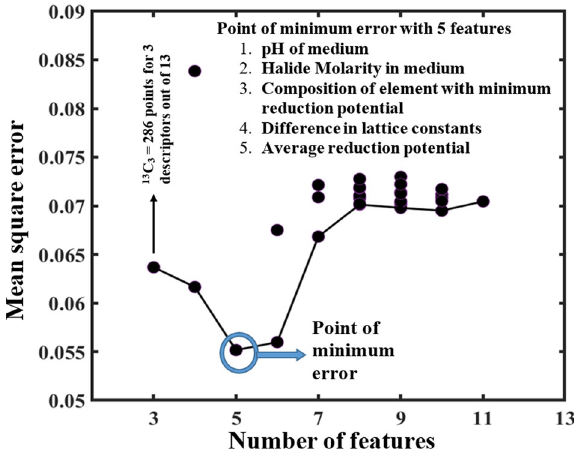
Fig. 4 MSE of the GBR model versus number of descriptors. Data are from numerous descriptor combinations from 1 to 13 for the absolute difference of predictions and experimental values, at least 19 out of 25 test data are within 2.5 times that of the experimental values. The lowest points represent the best regressor for a given number of descriptors. y -axis is limited for clarity to only those data that are <0.09. In actuality, there are 13 C n values for any given number of descriptors (n), as shown for n = 3 a total of 286. MSE does not show a trend with the number of descriptors and is minimum for a set of 5 descriptors (listed in fi gure).